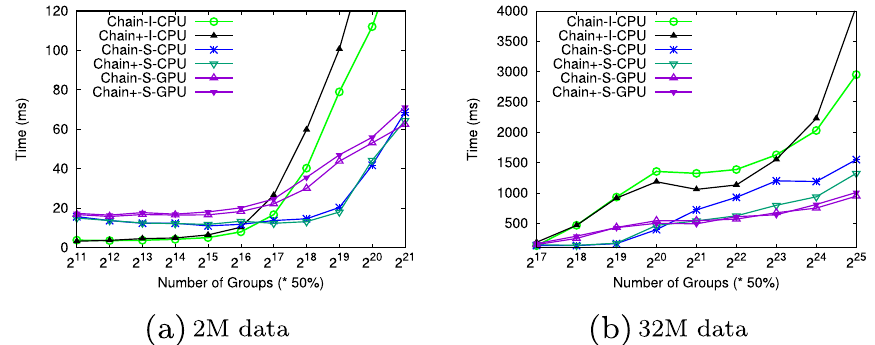
Fig. 7 Comparison between two kinds of chained hashing as the number of groups changes with different data sizes